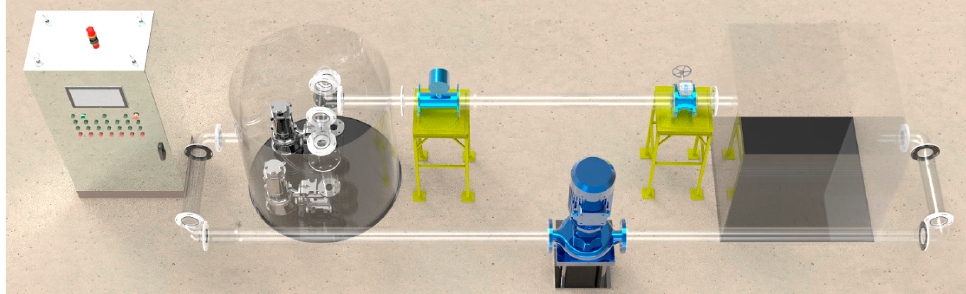
Figure 13. Three-dimensional model of centrifugal prefabricated pumping station.